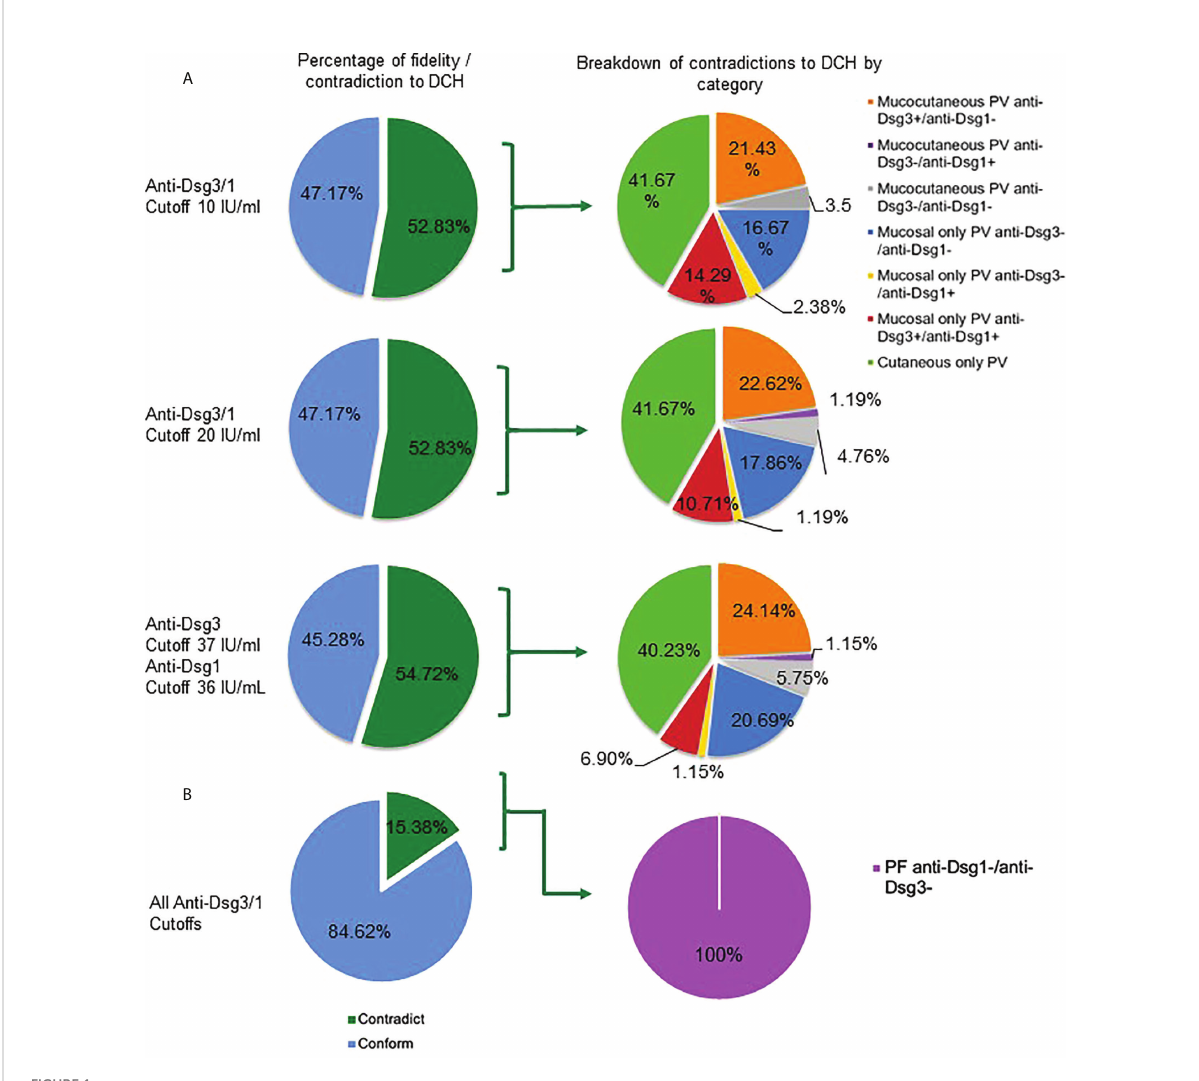
FIGURE 1 Contradictions to the DCH are consistent between different antibody cutoff values. (A) In active PV subjects (n = 159), more than half contradict the DCH based on their clinical lesions and autoantibody pro fi le across all cutoffs for anti-Dsg3 and -1 positivity (10 IU/mL, 52.83%; 20 IU/mL, 52.83%; 37&36 IU/mL, 54.72%) (dark green shading in left column at a cut-off of 10 IU/ml, 20 IU/ml, and 36/37 IU/ml). Subjects that contradict the DCH were classi fi ed into seven categories based on how a PV subject may contradict the DCH (right column): i) mucocutaneous PV in the presence of the following antibody patterns: a) anti-Dsg1-/3+, b) anti-Dsg1+/3-, and c) anti-Dsg1-/3-, ii) mucosal only PV carrying a) anti- Dsg1-/3-, b) anti-Dsg1+/3-, and c) anti-Dsg1+/3+, and iii) cutaneous only PV (with any antibody pattern). (B) For active PF subjects (n = 13), we found that 15.38% across all cutoffs do not follow the DCH according to their lesion location and anti-Dsg1 and -3 positivity at the same visit. The only contradiction seen in the PF group was the absence of both anti-Dsg1 and